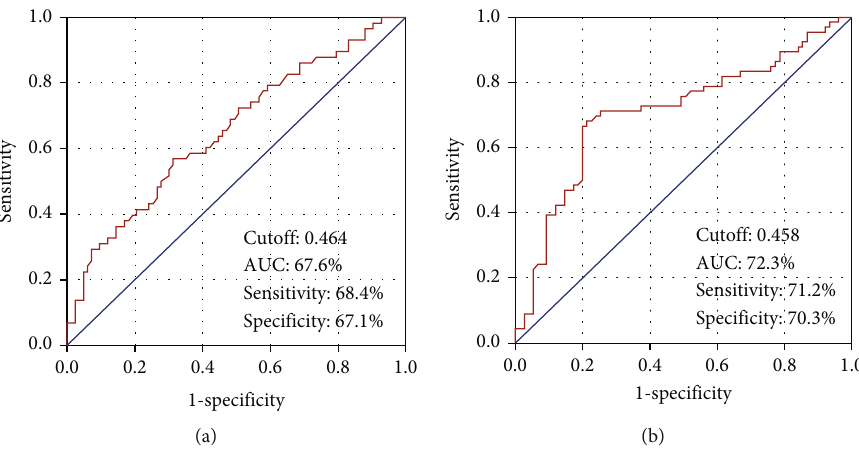
Figure 1: Results of receiver operating characteristic (ROC) curve analyses for (a) progression-free survival and (b) overall survival.